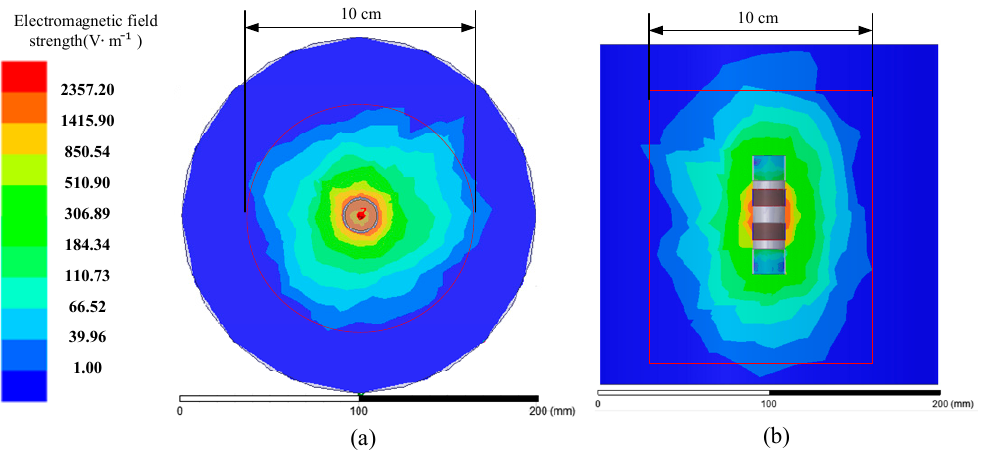
Figure 11. Electric field distribution of the bimetallic ring probe: ( a ) top view and ( b ) side view.